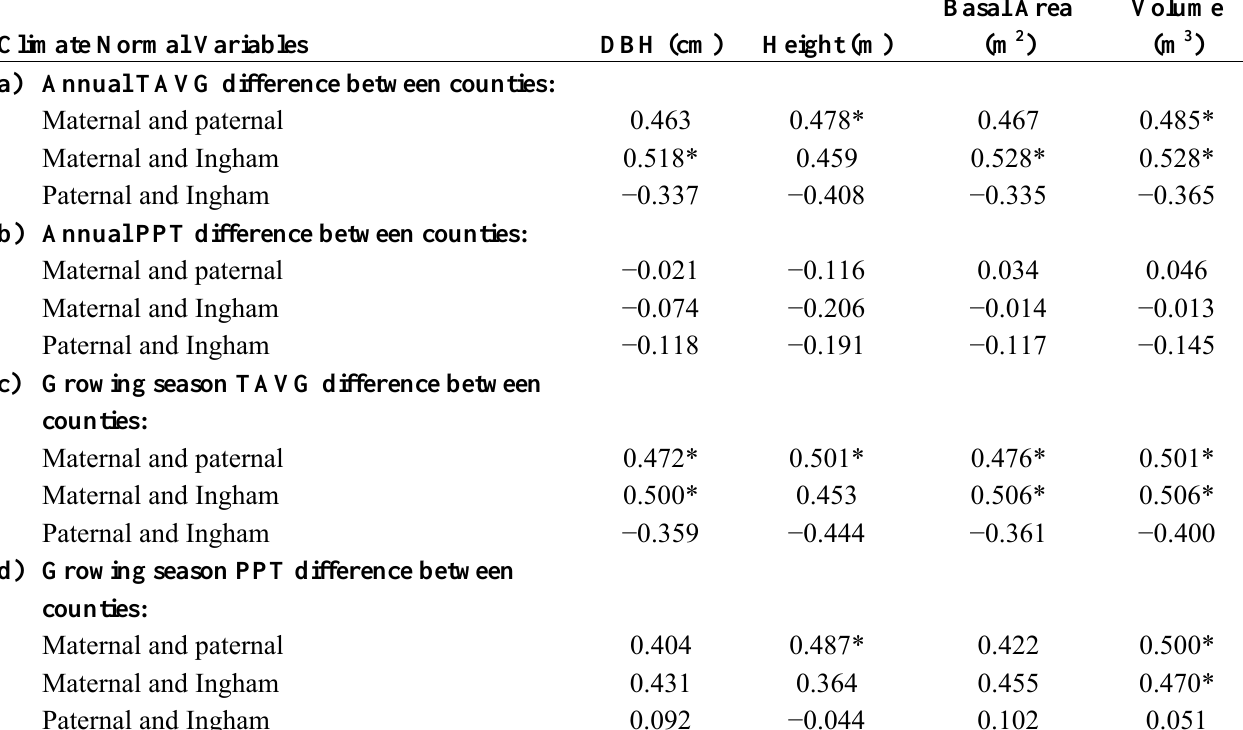
Table 4. Pearson correlation coefficients between growth characteristics of 18 full-sib families of hybrid poplar ( P. × smithii ) and climatic normal variables (reference period of 1971–2000). Climate variable abbreviations noted at end of